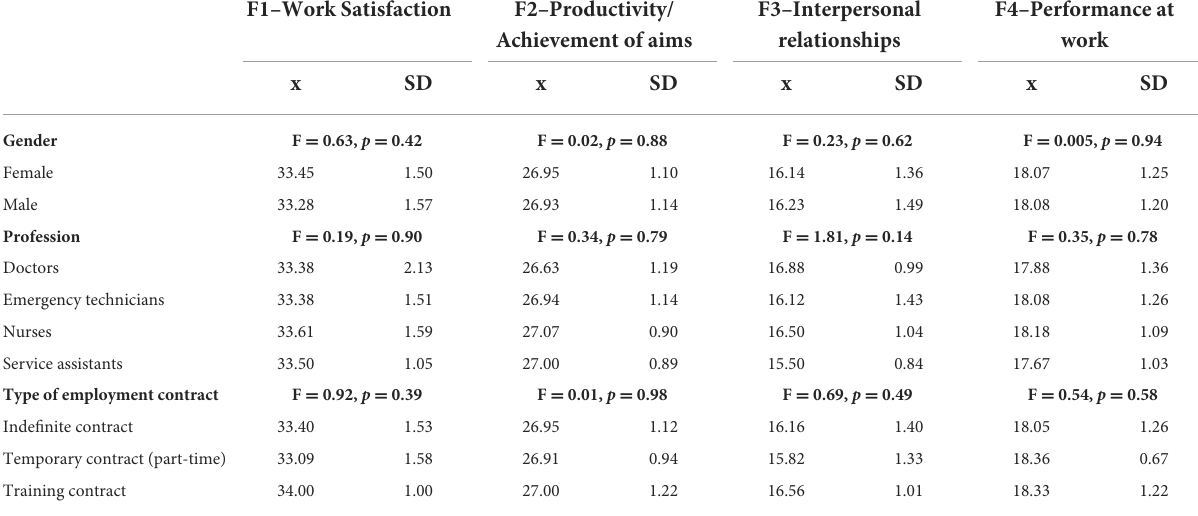
TABLE 1 Impact of variables: gender, profession, type of employment contract on factors of work